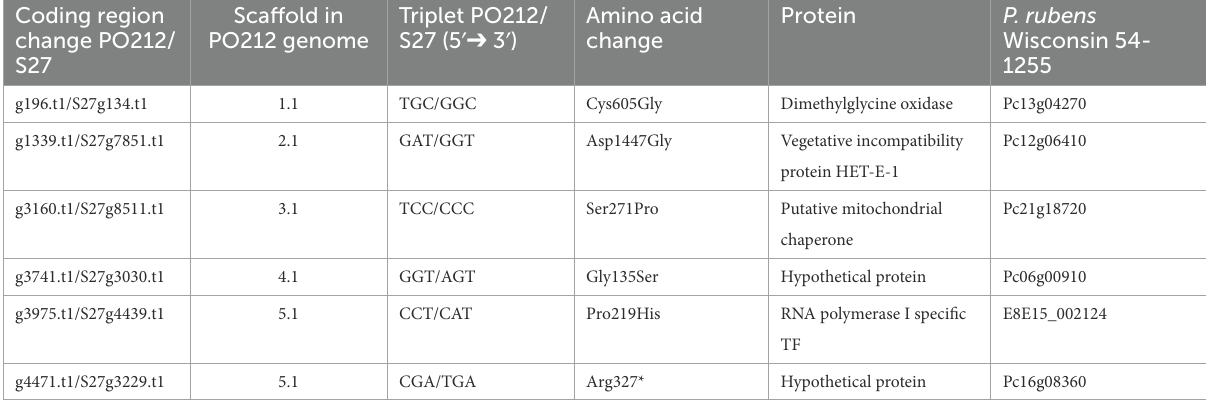
g3741.t1/S27g3030.t1